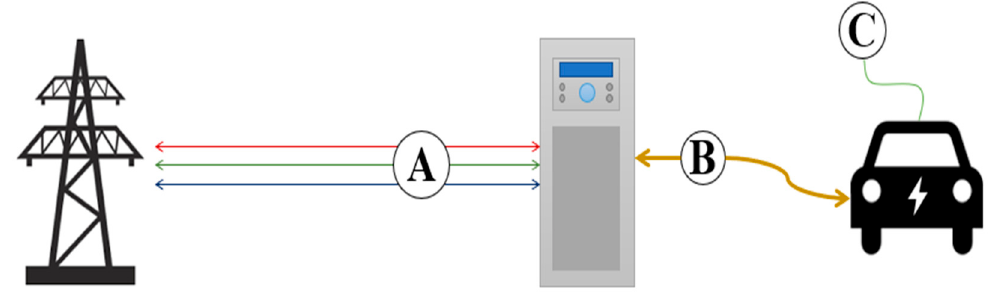
Figure 5. Measuring points of the charging–discharging process.